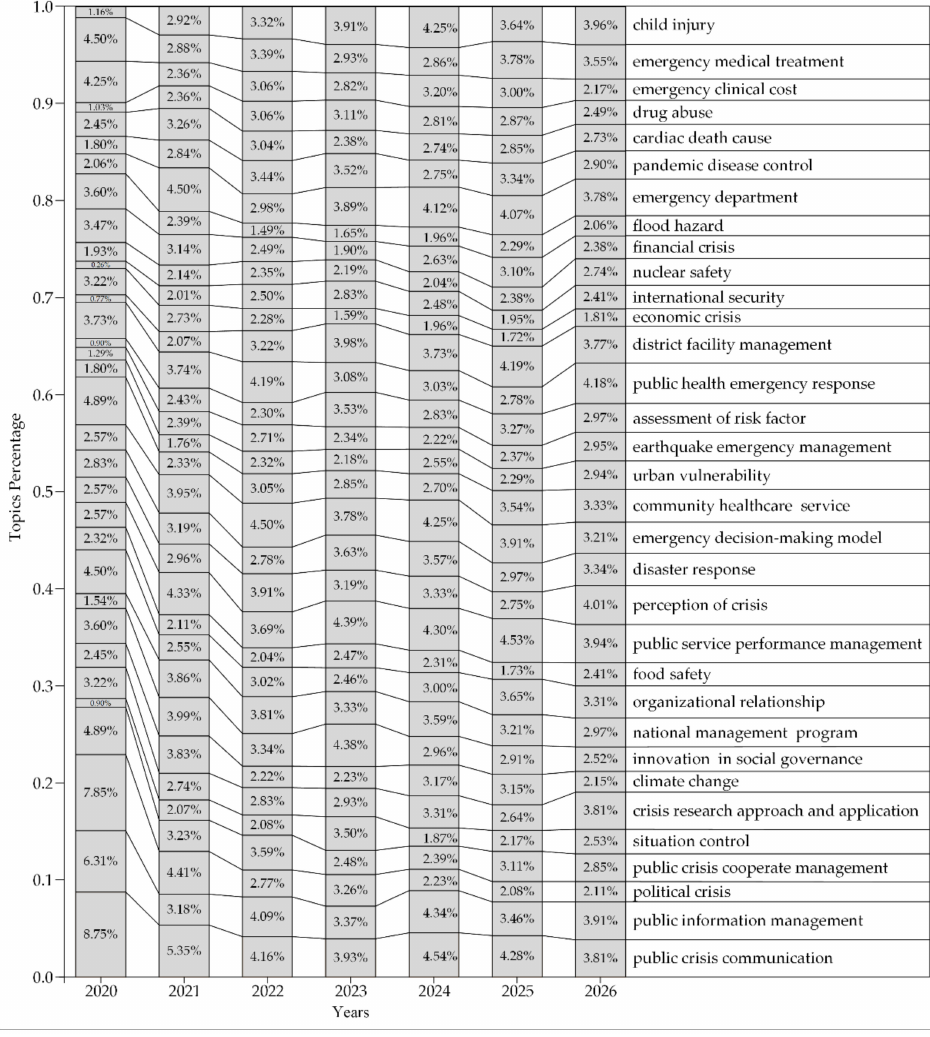
Figure 10. Prediction of the topics